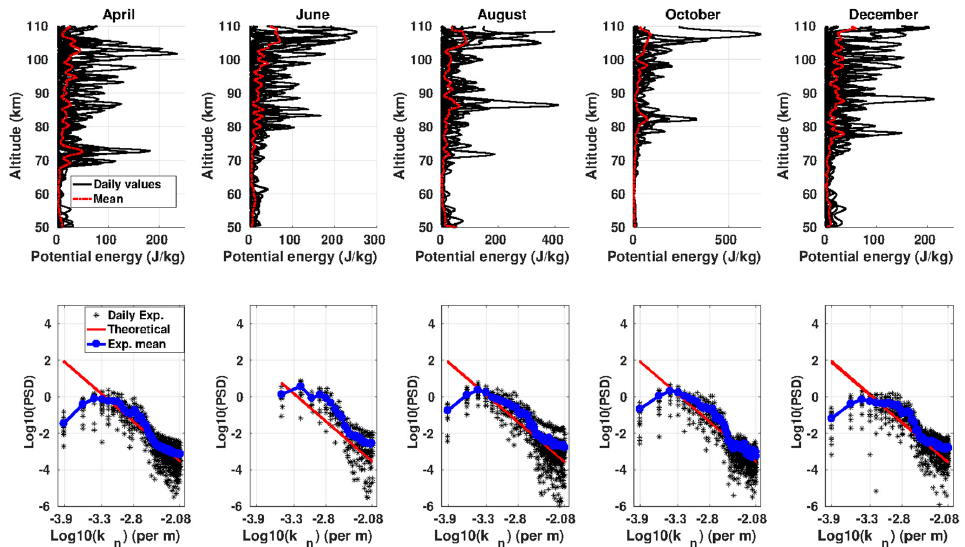
Figure 10. Gravity wave potential energy versus altitude (km) ( top panels ) and logarithm of theoretical and experimental PSD versus logarithm of vertical wave number ( bottom panels ) in the year 2013. The top panels show daily (black lines) and mean (red broken line) gravity wave potential energy versus altitude for each month.